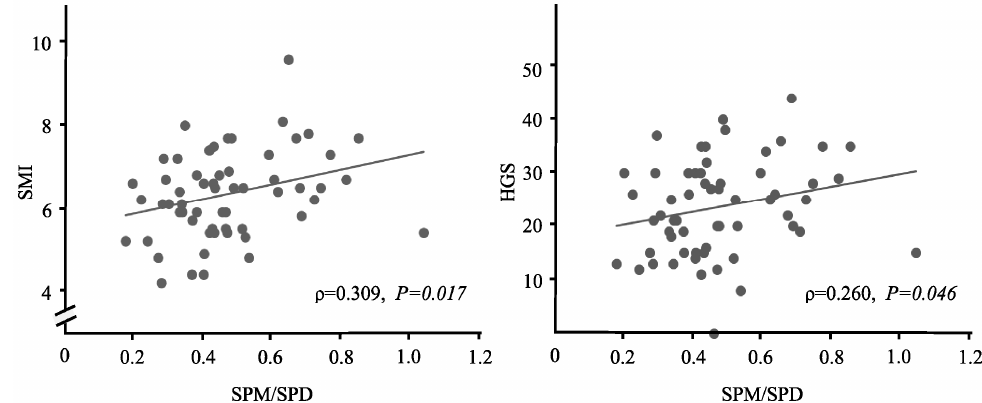
Figure 3. SPM/SPD ratio positively correlated with the SMI and HGS. There was a significant positive correlation between the pre-dialysis whole-blood SPM/SPD ratio and SMI ( left ) and between the SPM/SPD ratio and HGS ( right ) in dialysis patients. The correlation coefficients ( ρ ) were calculated using Spearman’s rank correlation coefficient. SPD: Spermidine, SPM: Spermine, SMI: Skeletal muscle mass index.